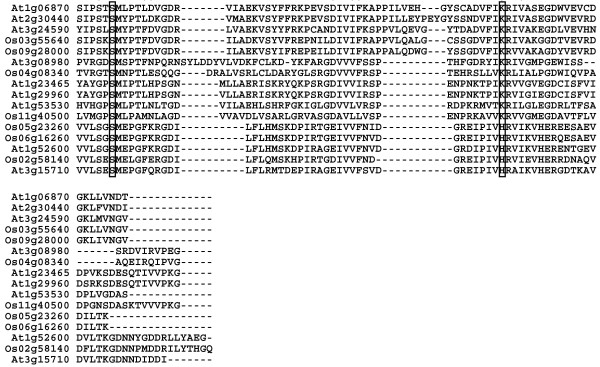
Multiple sequence alignment of the Type I Spase domain region of the annotated Arabidopsis and rice Type I Spase-like proteins. The catalytic dyad residues are indicated. Gene names correspond to those in Additional files 1 and 2. For brevity, rice gene names have been shortened to OsXXg##### instead of LOC_OsXXg#####, XX referring to chromosome 1–12 and a 5 digit number assigned to each gene. The variations in the second residue (K/H) of catalytic dyad can be identified here (see text for details).